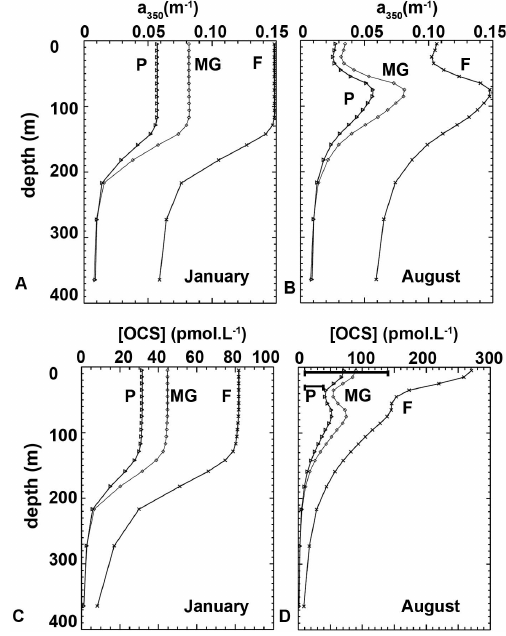
Figure 5. Monthly mean vertical profiles of a 350 (top row) and OCS concentration (bottom row) in January (left column) and August (right column) simulated by NEMO-PISCES in a 1-D run at the BATS site. The thick lines in (d) cover the range between minimal and maximal values as measured by Cutter et al. (2004). The differ- ent a 350 profiles are calculated using the formulations of Morel and Gentili (2009) (MG, diamonds), Preiswerk and Najjar (2000) (P, triangles) or based on MODIS Aqua data (F, black line). Symbols used on OCS concentration profile on bottom row indicate which a 350 –chlorophyll relationship was used in the